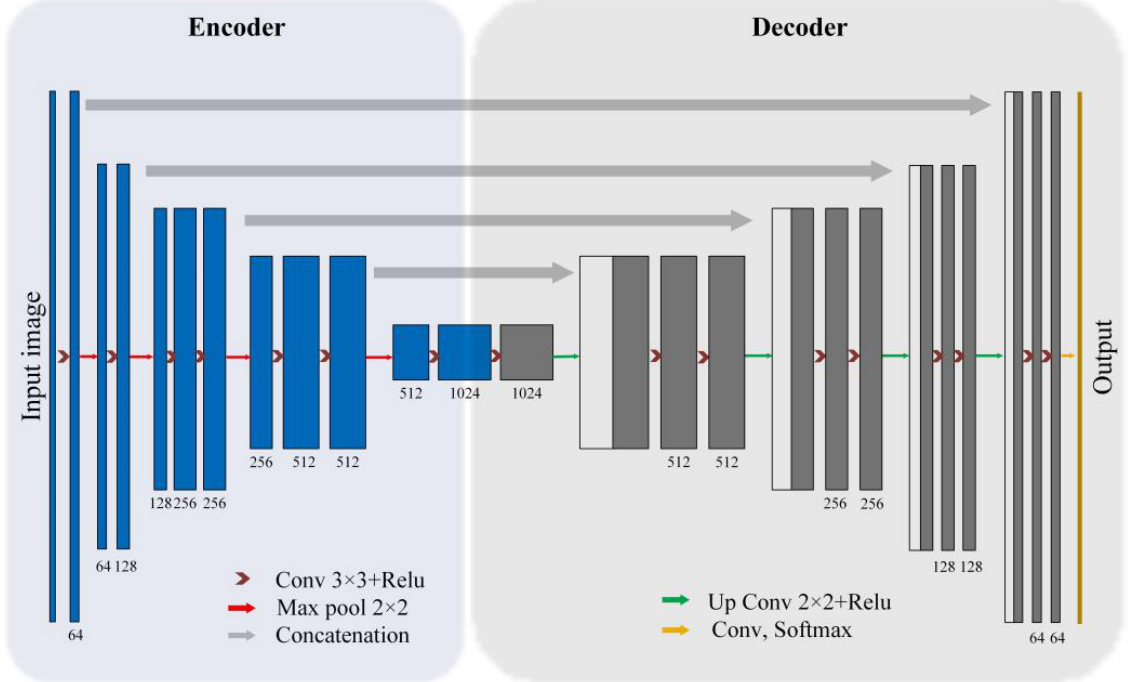
Figure 4. Network structure. It was built based on U-Net, including encoder and decoder. After inputting images of different bands, the net can output rice extraction images with the same spatial resolution.